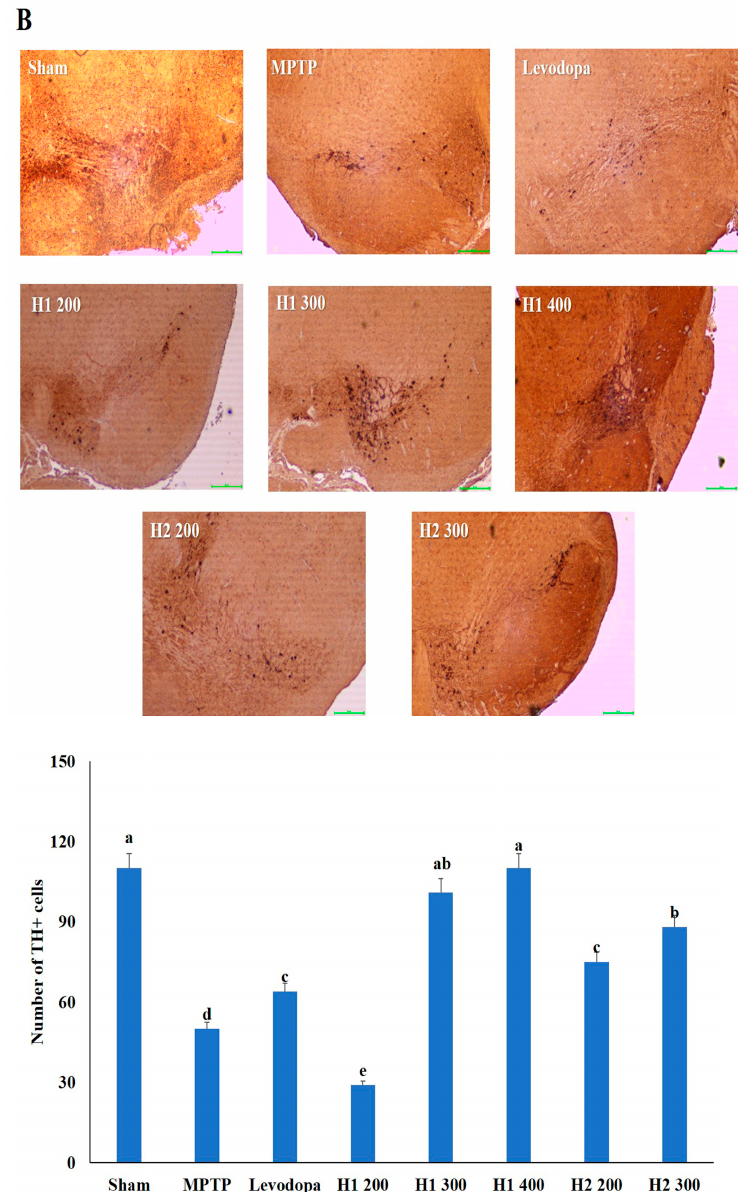
Figure 4. Representative photomicrographs (40× magnification) of ( A ) hematoxylin and eosin-stained brain sections and ( B ) immunohistochemical staining of tyrosine hydroxylase -positive (TH+) neurons (scale bar, 100 μ m). Results are expressed as the mean ± the standard deviation. Level of statistical significance for a, b, c, d, and e is p < 0.05 (Duncan’s multiple range test).